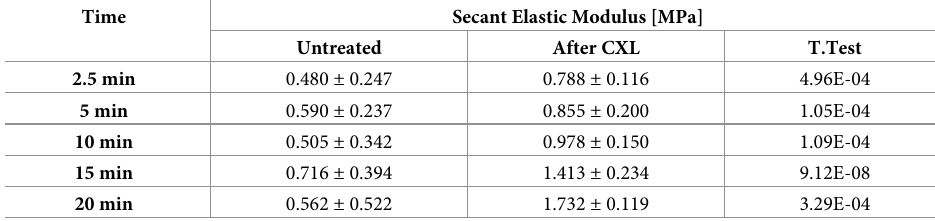
Table 3. Average values and standard deviation of the equivalent secant modulus obtained from the experimental data through the linearized shell